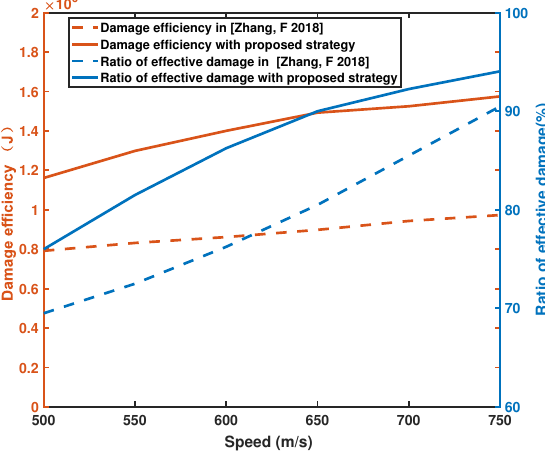
Figure 17. Monte Carlo simulation of different pursuer speeds